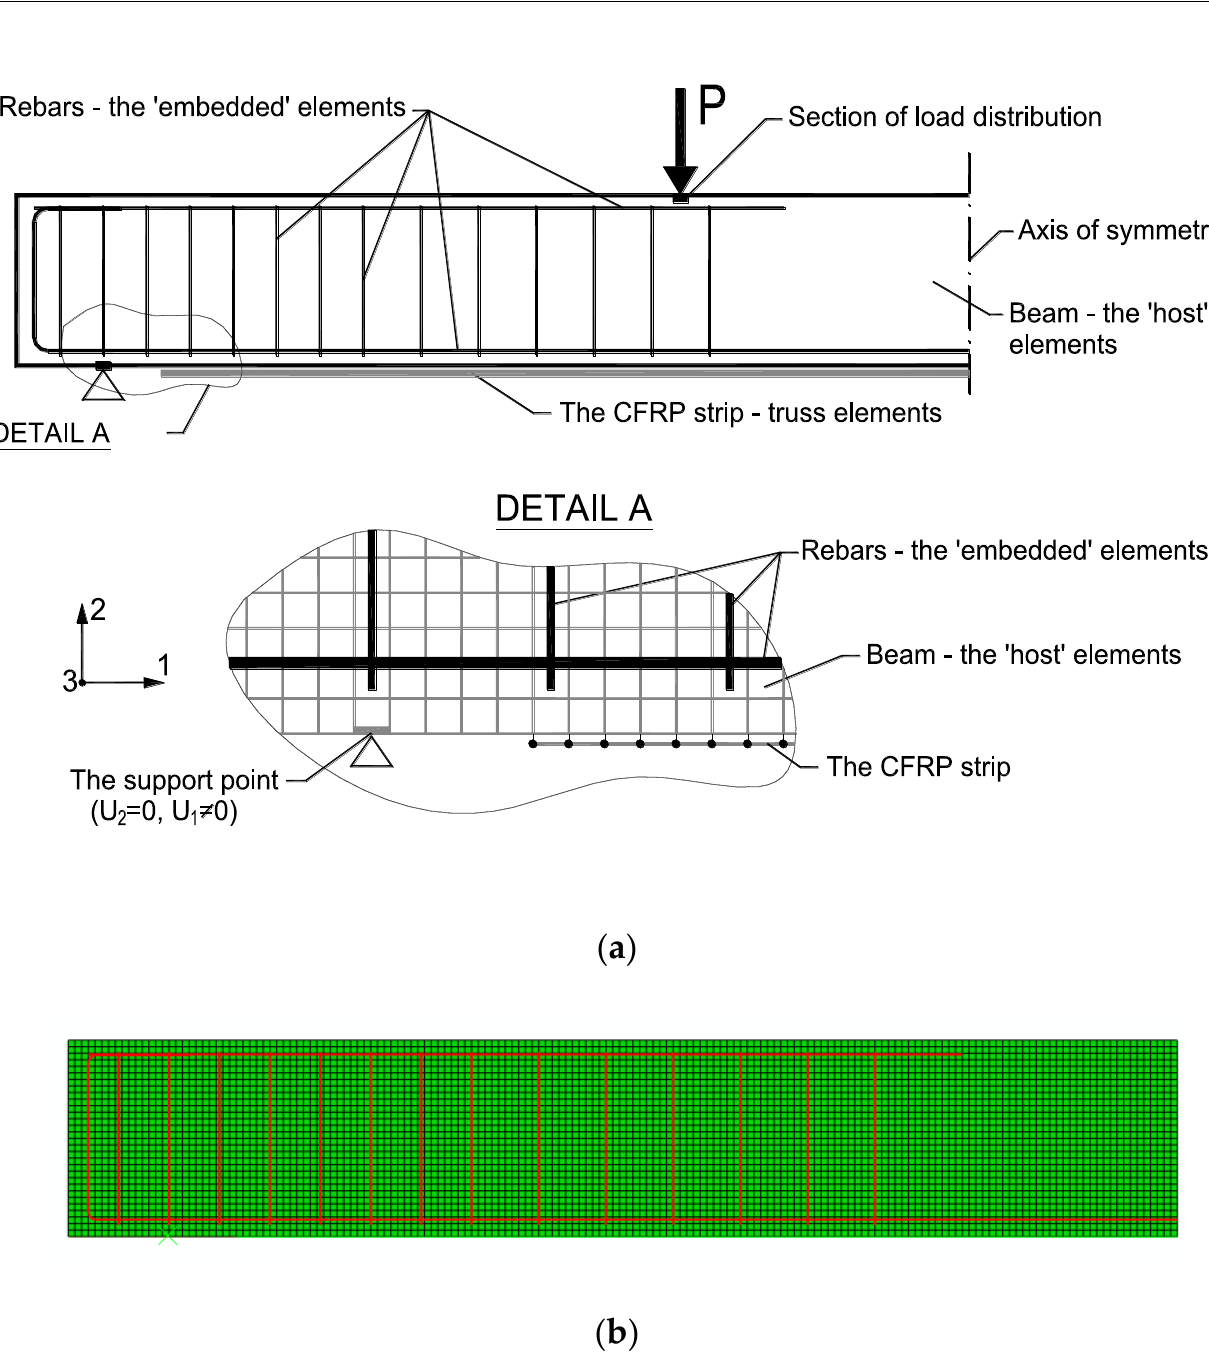
Figure 4. Layout of 2D model: ( a ) description of half-beam model in 2D analyses; and ( b ) numerical model with rod elements embedded in host elements of concrete.